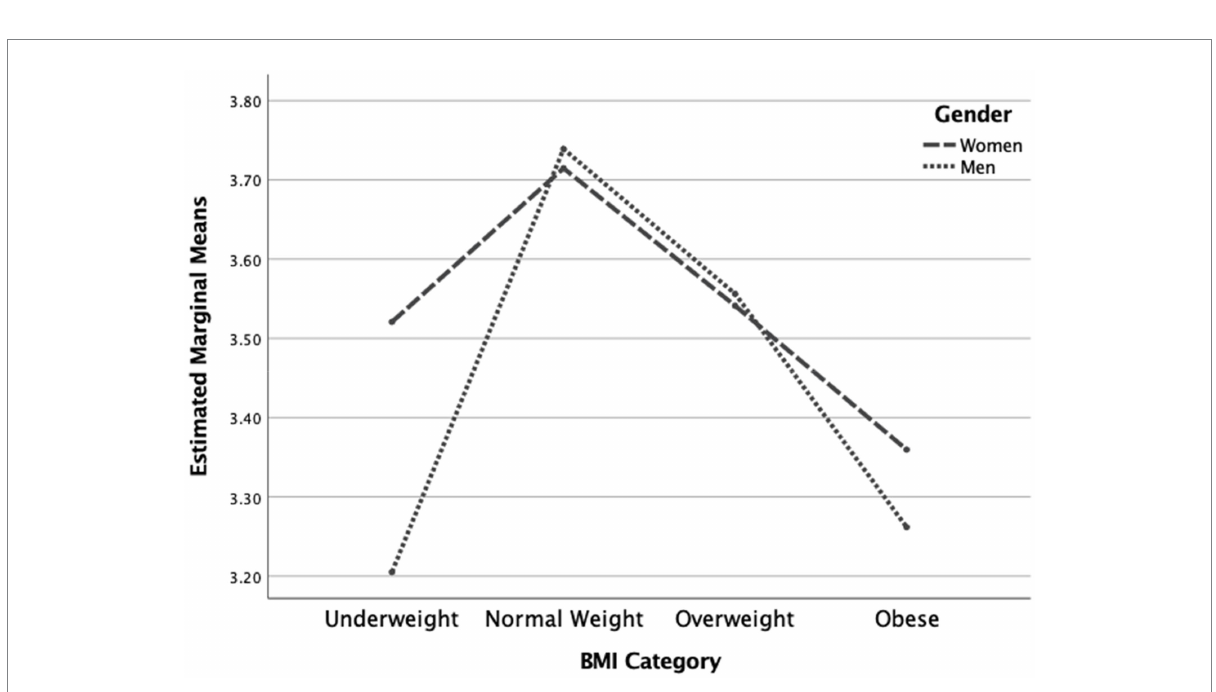
FIGURE 5 Interaction effect for body food choice congruence. N = 1,312 ( n = 657 for women, and n = 655 for men), p <